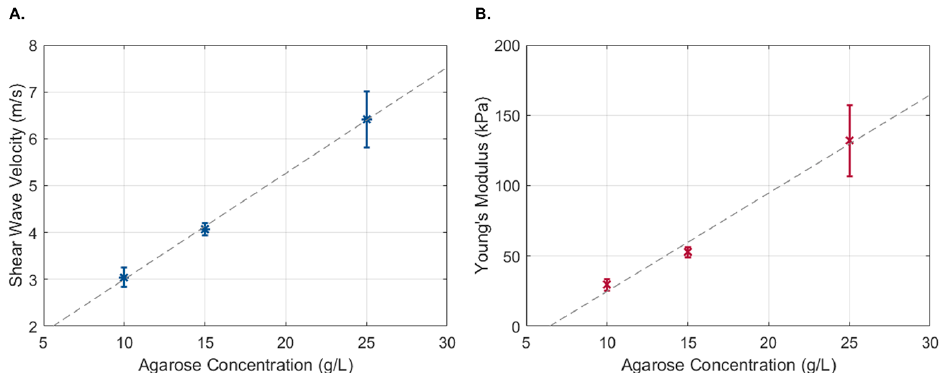
Figure 8. Shear wave propagation velocity ( A ) and Young’s modulus ( B ) as a function of agarose concentration. Data are presented as the mean ± standard deviation.